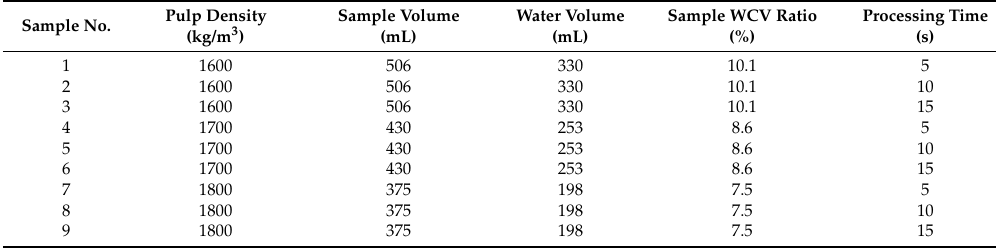
Table 2. Experimental parameters for copper ore wet grinding in EMM, solids mass 470 g and grinding media (10/1 type) mass 1500 g (9% of WCV). Sample